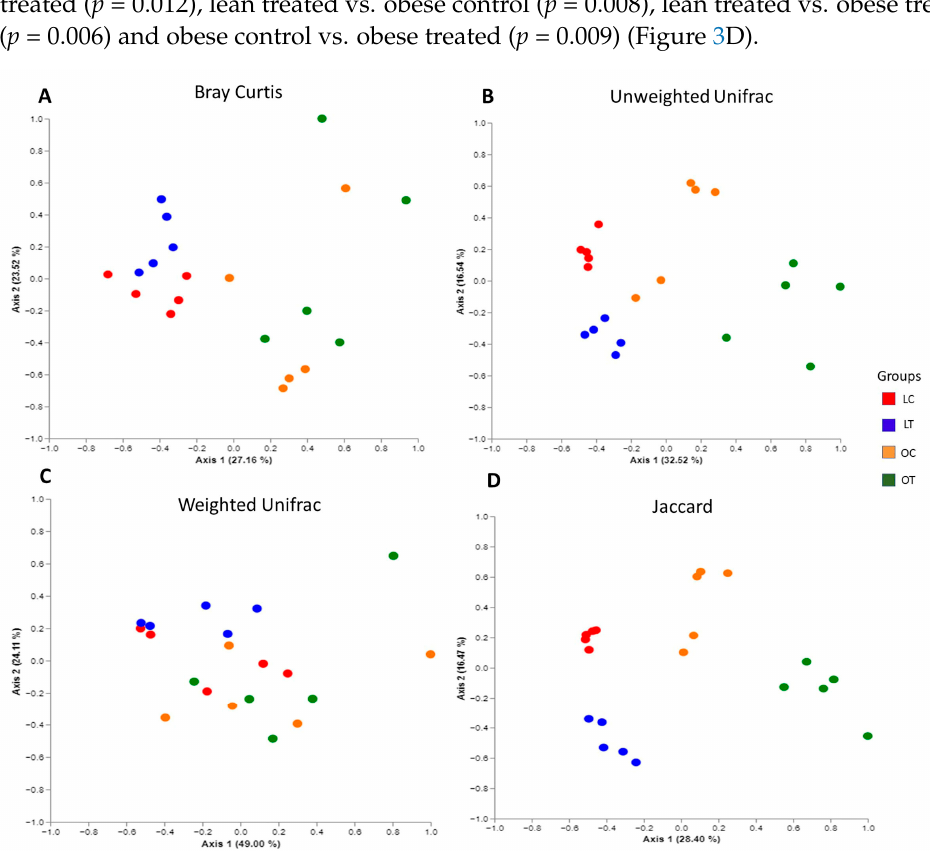
Figure 3. Composition changes in gut microbiota based on PCoA, including Bray Curtis ( A ), unweighted UniFrac ( B ), weighted UniFrac ( C ) and Jaccard ( D ) analyses of the lean control (LC), lean treated (LT), obese control (OC) and obese treated (OT) groups.